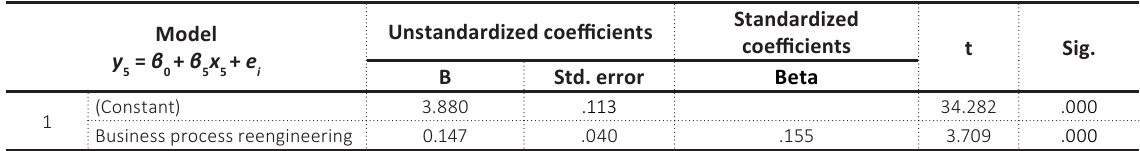
Table 3. Summary of the simple linear regression between business process reengineering and operational costs ( n =